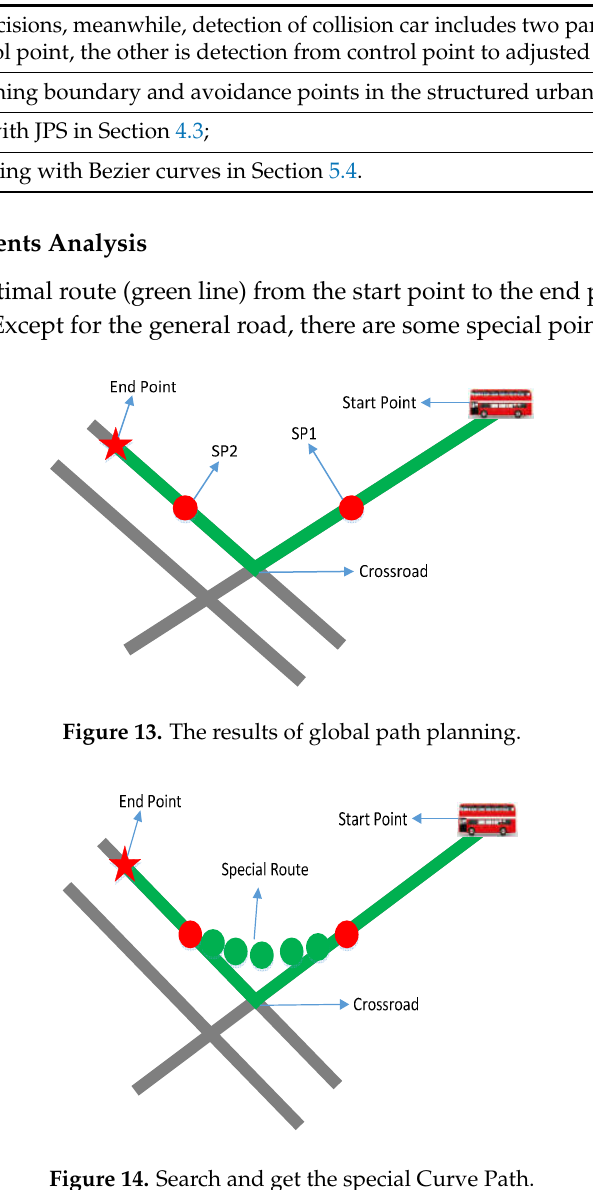
Table 1. Local Path Planning based on JPS in Structured Environment.